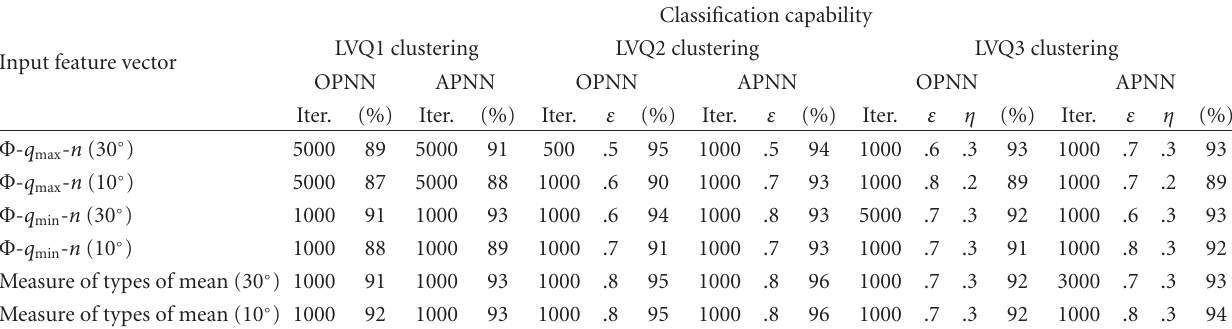
Table 6: Comparison of classification capability of OPNN and APNN with LVQ versions’ clustering algorithms.